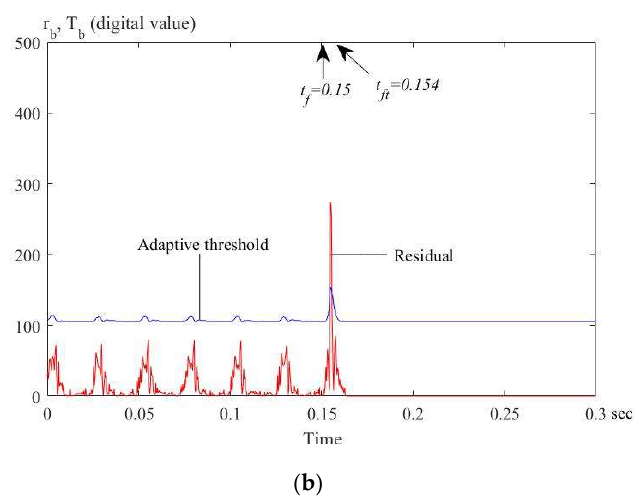
Figure 23. Measured results of the b -phase when the b -phase current sensor was faulty: ( a ) measured and estimated current; ( b ) residual and adaptive threshold.